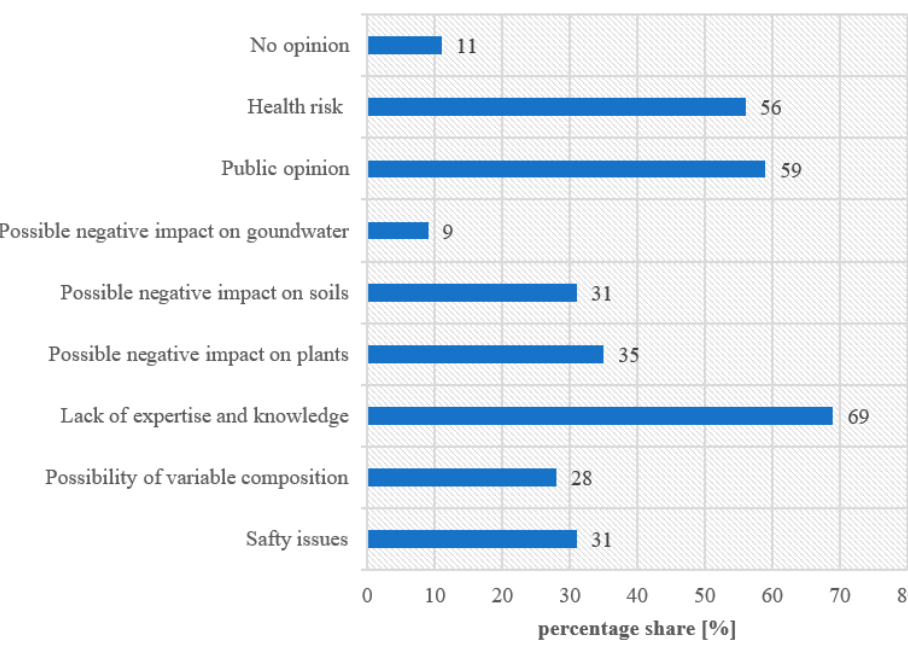
Figure 6. Preferred form of fertilizers.